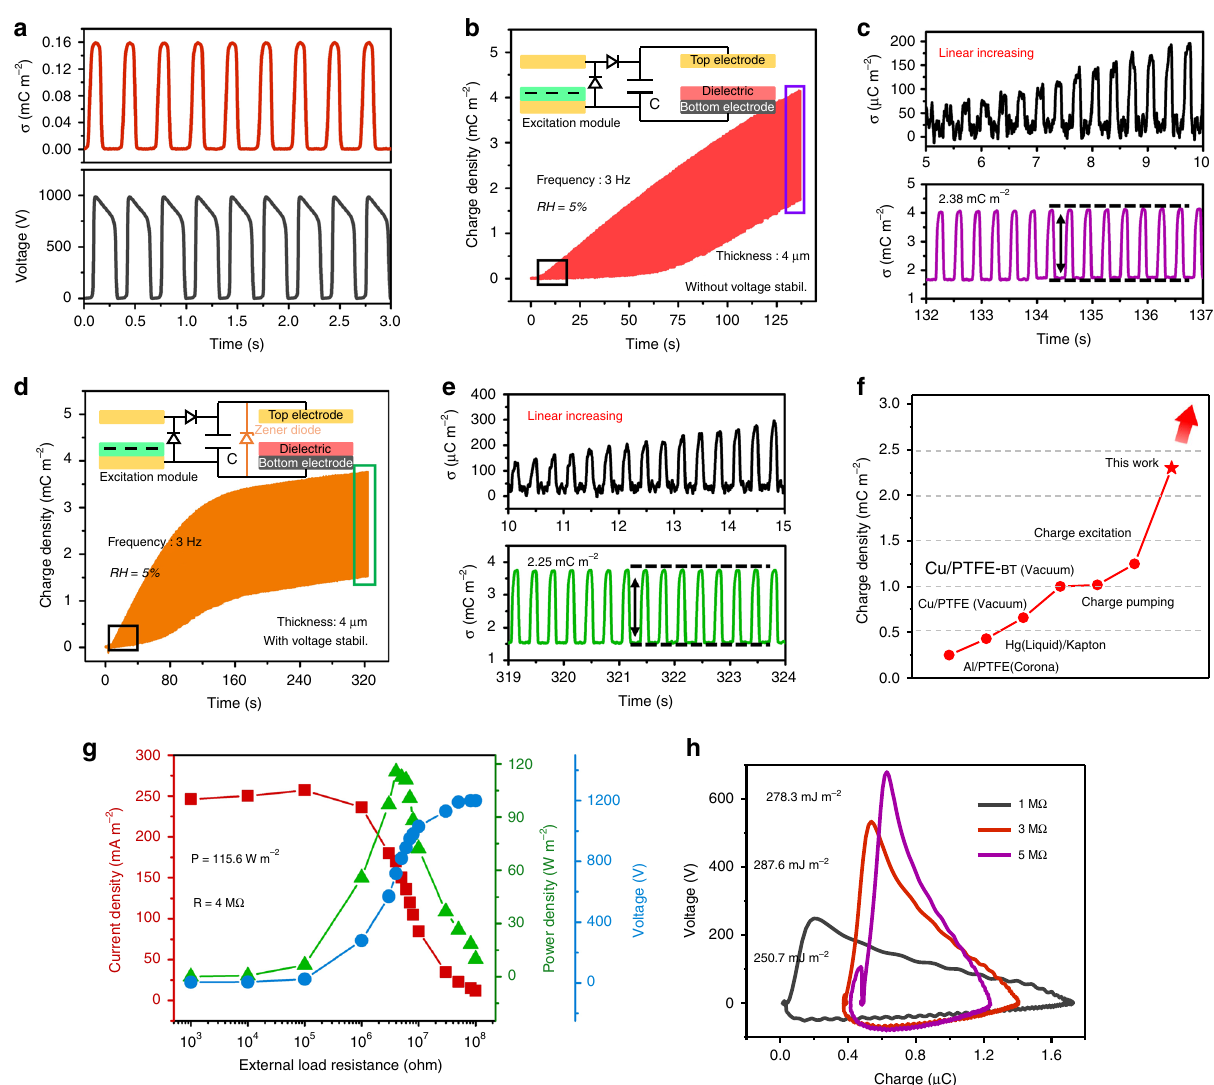
Fig. 3 Electric output of CE-TENG with optimized materials and structure. a Output charge and voltage curve of external excitation TENG (operation frequency: 1 Hz). b Dynamic charge density output of CE-TENG without using zener diode. c Enlarged initial charge accumulation curve (up) and saturation output state (down). d Dynamic charge output of CE-TENG with using zener diode. e Enlarged initial charge accumulation (up) and saturation output state (down). f Output charge density comparison in the development stage of TENG. g Output current, voltage and peak power under various external load (operation frequency: 3 Hz). h V – Q curve of CE-TENG under optimized load resistance (operation frequency: 3 performance characteristics. The output charge density of CE- TENG with 4 μ m dielectric under a constant environment and application of different excitation voltages are shown in Fig. 2e. With the voltage raising and reaching over 400 V, the output charge density linearly increases and gets the saturated due to the limitation of air-breakdown effect discussed above. In this way, the output charge with different dielectric thickness is measured under relative humidity of 5% as shown in Fig. 2f (red dot). The SEM of dielectric surface and cross-section view are demonstrated in Supplementary Fig. 7 . Compared with previous works (dash line) 18,19,30,37,38 , the maximum charge density holds a certain improvement. The possible reason is that the previous theoretical and experimental results were both obtained in the relative humidity around 40 – 70%, which would have high impact on the atmospheric constant A and thus affect the air breakdown of TENG. By adjusting the constant A from 2E7 to 5E7, the experimental results get well matched with the theory (green solid line). In addition, the measured results of atmospheric humidity